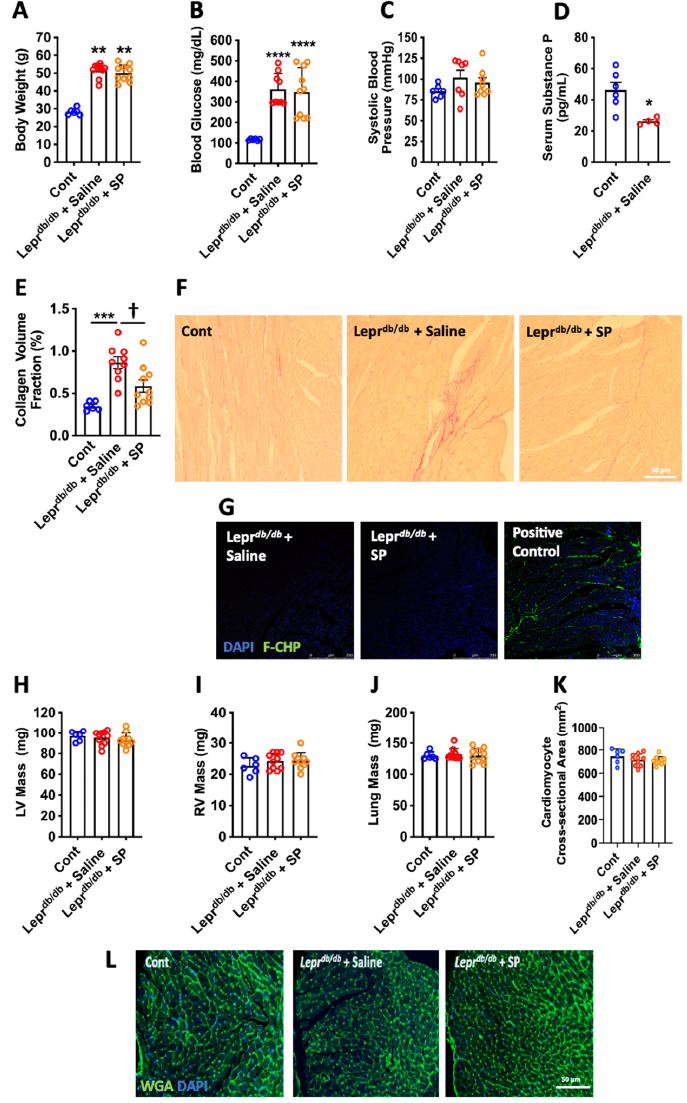
Figure 1. Lepr db/db mouse biometrics. ( A ) Body weight; ( B ) blood glucose; and ( C ) systolic blood pressure in control (Cont, n = 6), Lepr db/db + saline ( n = 10), and Lepr db/db + SP mice ( n = 10); ( D ) serum SP levels in Cont ( n = 6) and Lepr db/db + saline mice ( n = 4). Data are expressed as mean ± SD and were analyzed by one-way ANOVA with Tukey post hoc test, except for serum SP levels, which are expressed as mean ± SEM and were analyzed by unpaired t-test. * p < 0.05 vs. Cont, ** p < 0.01 vs. Cont, **** p < 0.0001 vs. Cont. Replacement SP ameliorates cardiac fibrosis. ( E ) Collagen volume fraction quantification; and ( F ) representative images of picrosirious red staining for Cont ( n = 6), Lepr db/db + saline ( n = 10), and Lepr db/db + SP mice ( n = 10). Data are expressed as mean ± SEM and were analyzed by one-way ANOVA with Tukey post hoc test; *** p < 0.001 vs. Cont, † p < 0.05 vs. Lepr db/db + saline. ( G ) Representative images of unfolded collagen as identified by FAM-conjugated collagen hybridizing peptide (F-CHP) labeling of LV sections. Positive Control = LV section boiled in H 2 O to damage collagen prior to labeling with collagen hybridizing peptide (green fluorescence = unfolded collagen, Blue = DAPI). Replacement SP does not alter organ hypertrophy. ( H ) LV mass; ( I ) RV mass; and ( J ) Lung mass; ( K ) cardiomyocyte cross-sectional area; and ( L ) representative images of wheat germ agglutinin (WGA) staining for Cont ( n = 6), Lepr db/db + saline ( n = 10), and Lepr db/db + SP mice ( n = 10). Data are expressed as mean ± SD and were analyzed by one-way ANOVA with Tukey post hoc test. (WGA = green, DAPI =